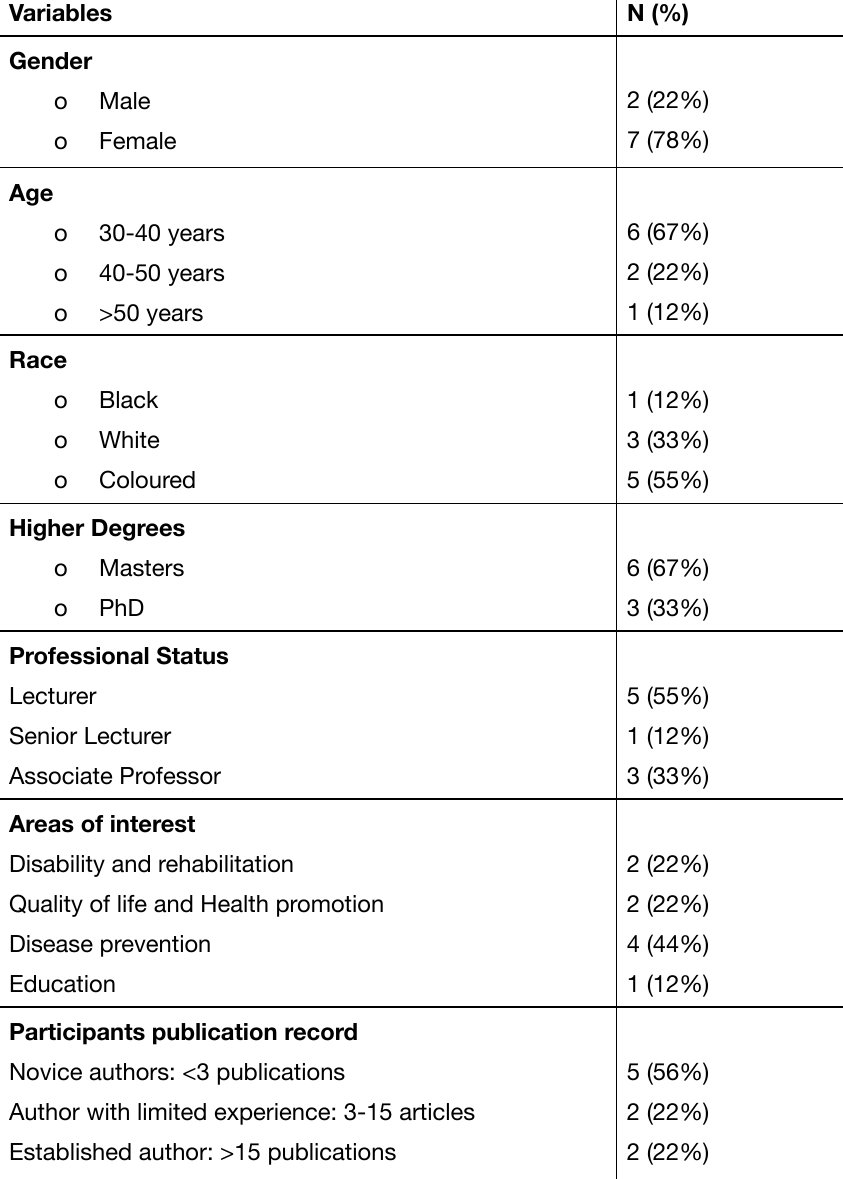
Table 3: Socio-demographic data Variables n